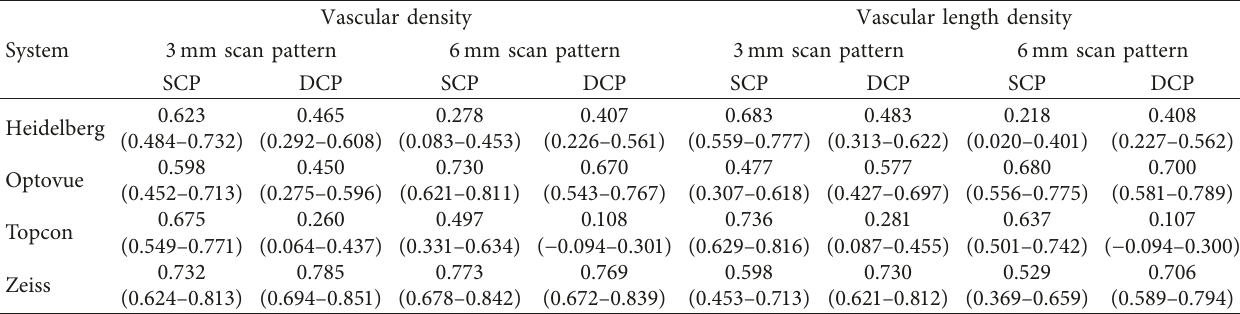
Table 2: Intraclass correlation coefficients (95% confidence interval) of the vessel density and vessel length density measurements derived with the four optical coherence tomography angiography systems using third-party software.